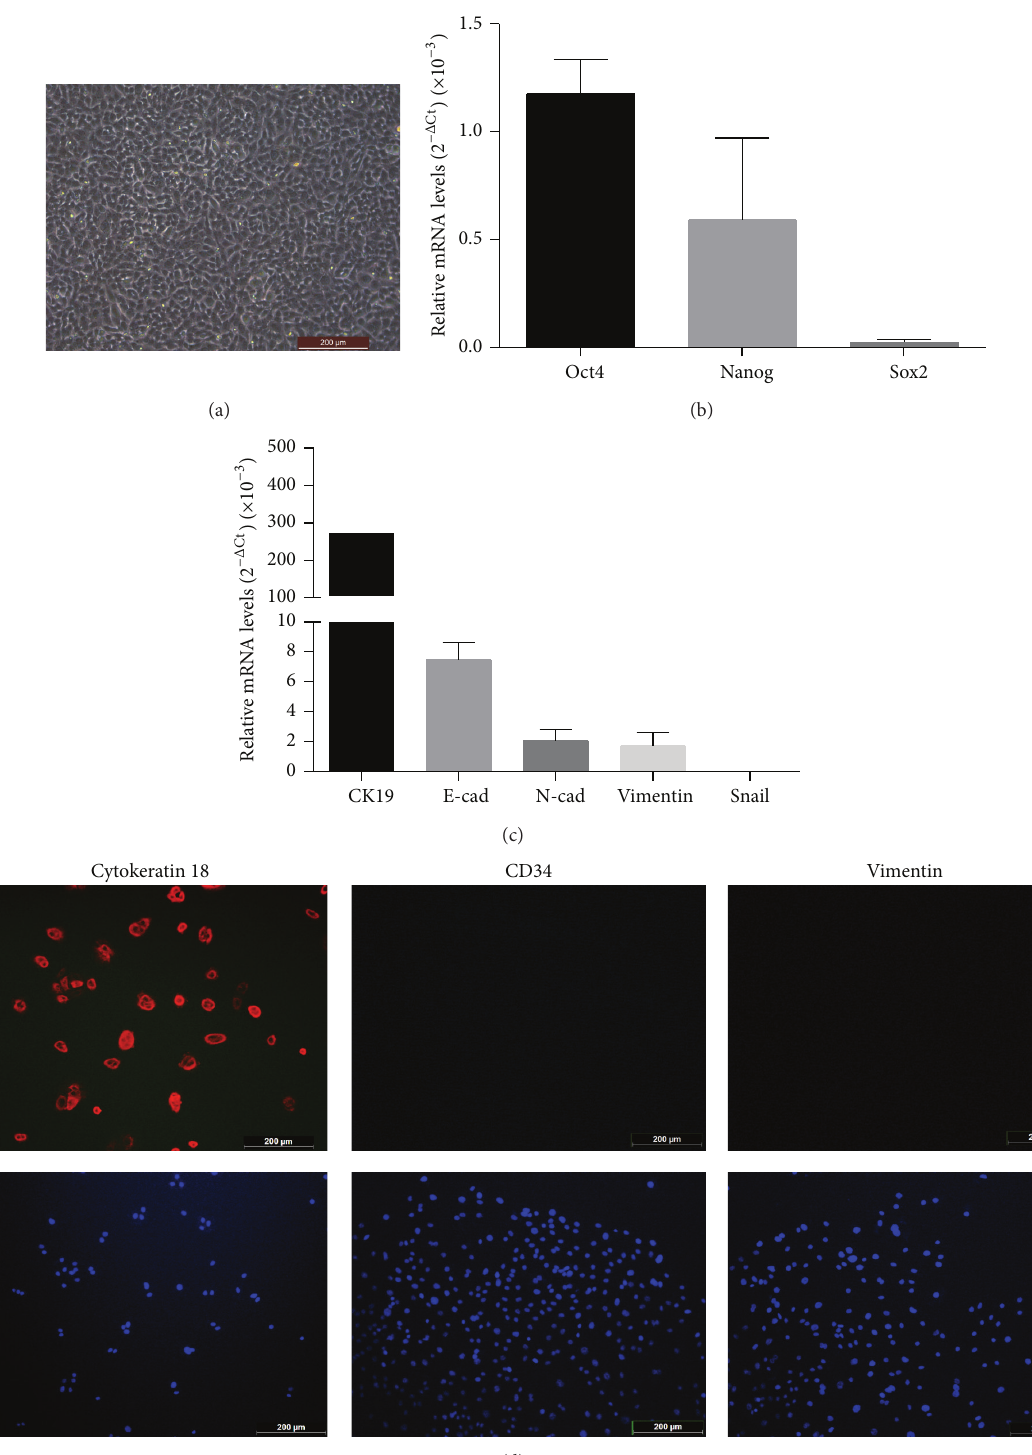
Figure 1: Identification and characterization of isolated hAECs. (a) The representative characteristics of hAECs under light microscope. (b) Expression of Oct-4, Nanog, and Sox2 (relative to a beta-actin internal control) in cultured hAECs by real-time PCR analysis. The results presented were the average values from five different donors. (c) The analysis of epithelial and mesenchymal markers expression (relative to a beta-actin internal control) in isolated hAECs by real-time PCR. The results presented were the average values from five different donors. (d) Immunofluorescence detection of Cytokeratin 18, CD34, and Vimentin in cultured hAECs. Scale bar: 200 𝜇